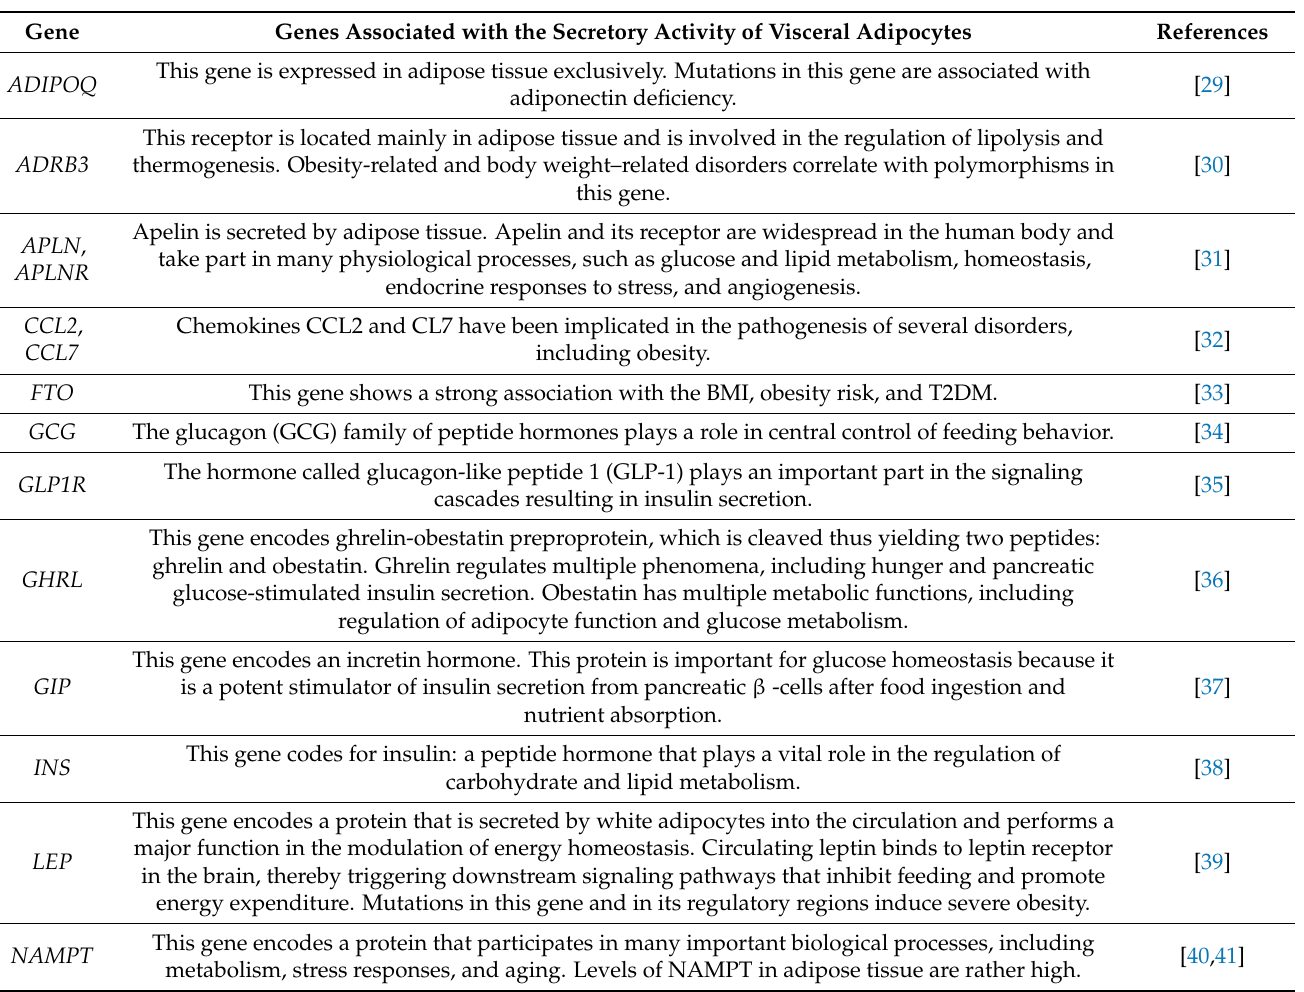
Table 1. Genes examined in this review that are associated with secretory activity of visceral